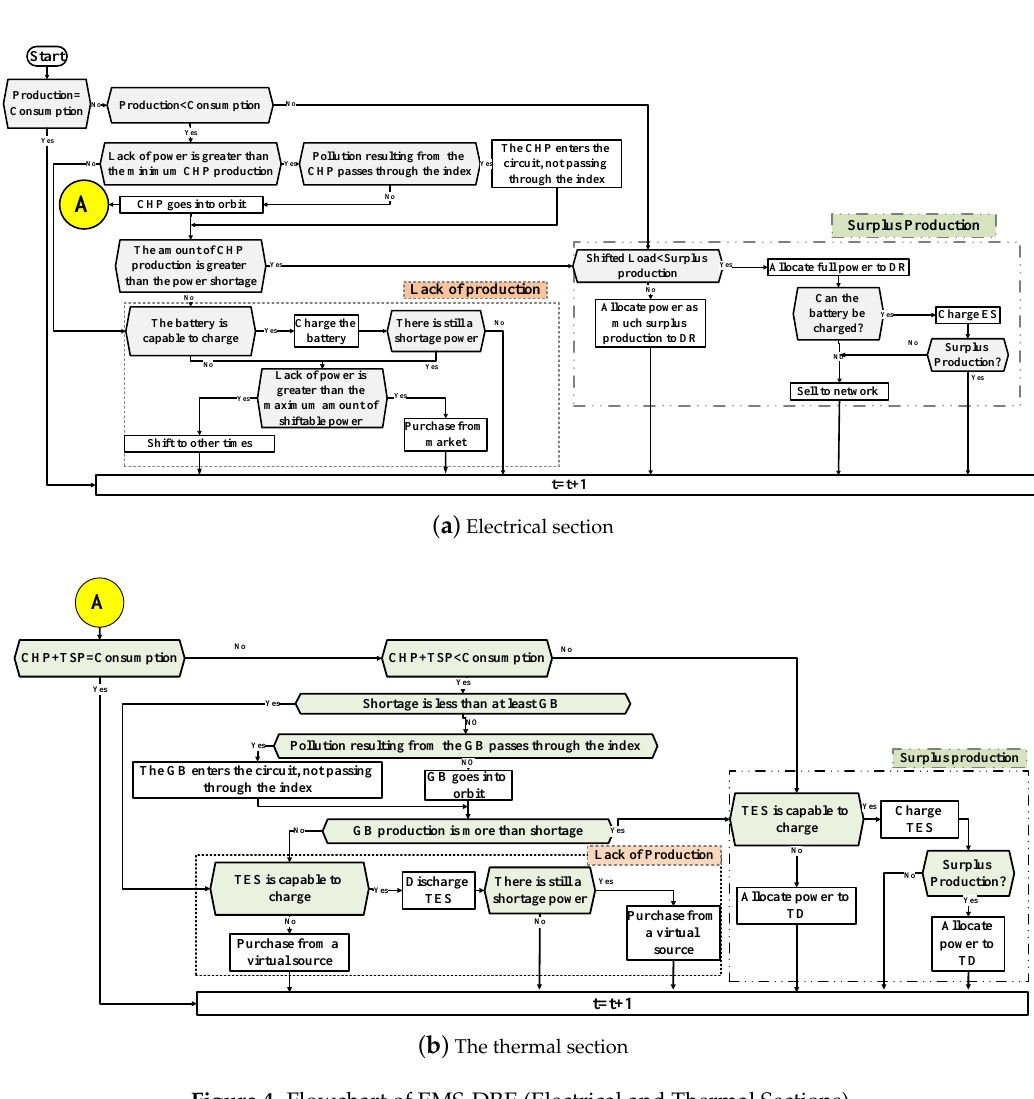
Figure 4. Flowchart of EMS-DRE (Electrical and Thermal Sections).